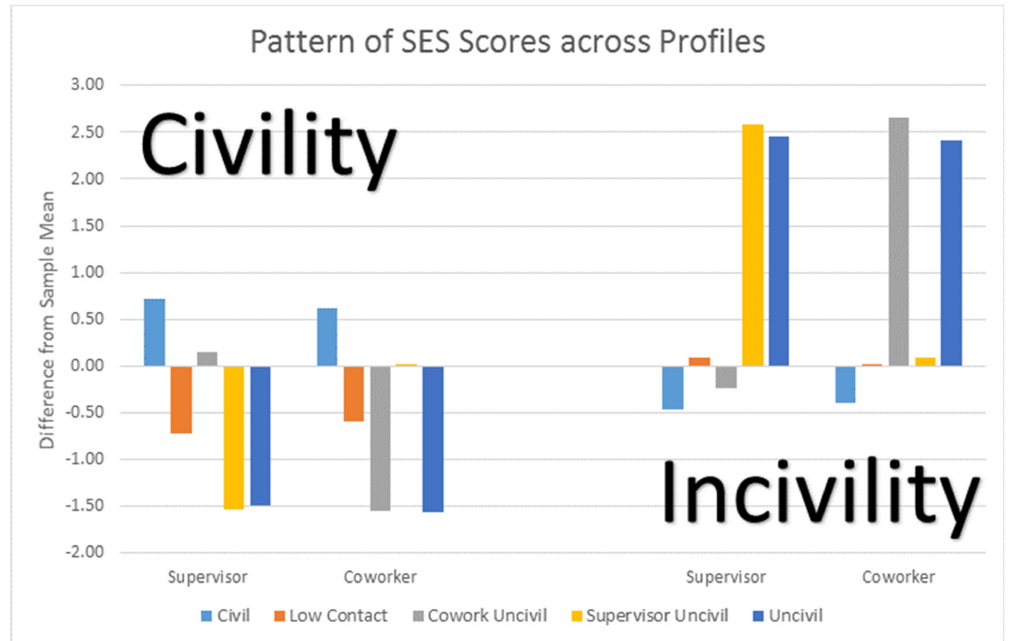
Figure 1. Pattern of SES scores across